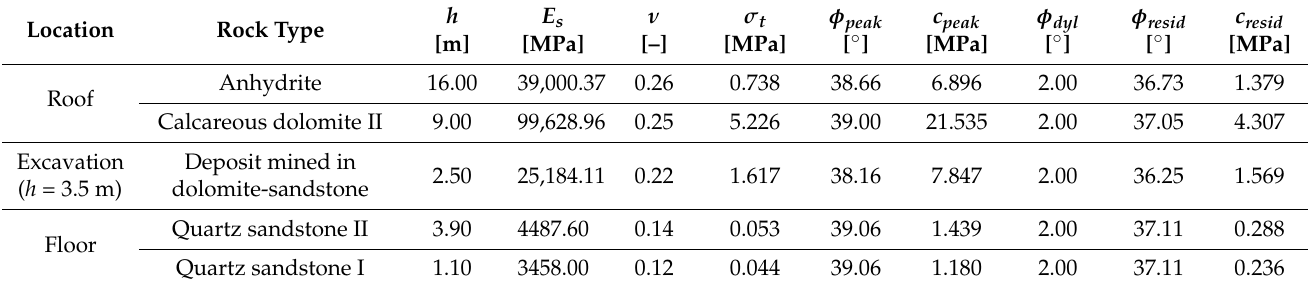
Table 4. Rock mass parameters adopted for the elastic-plastic numerical model with softening.